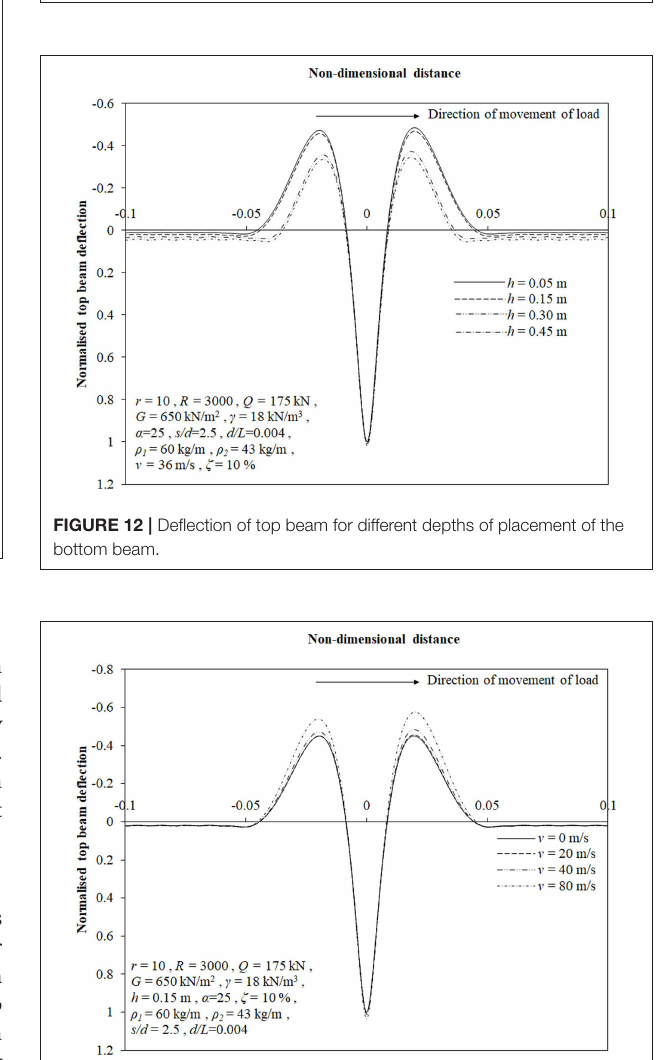
FIGURE 11 | Deflection of top beam at different values of R .